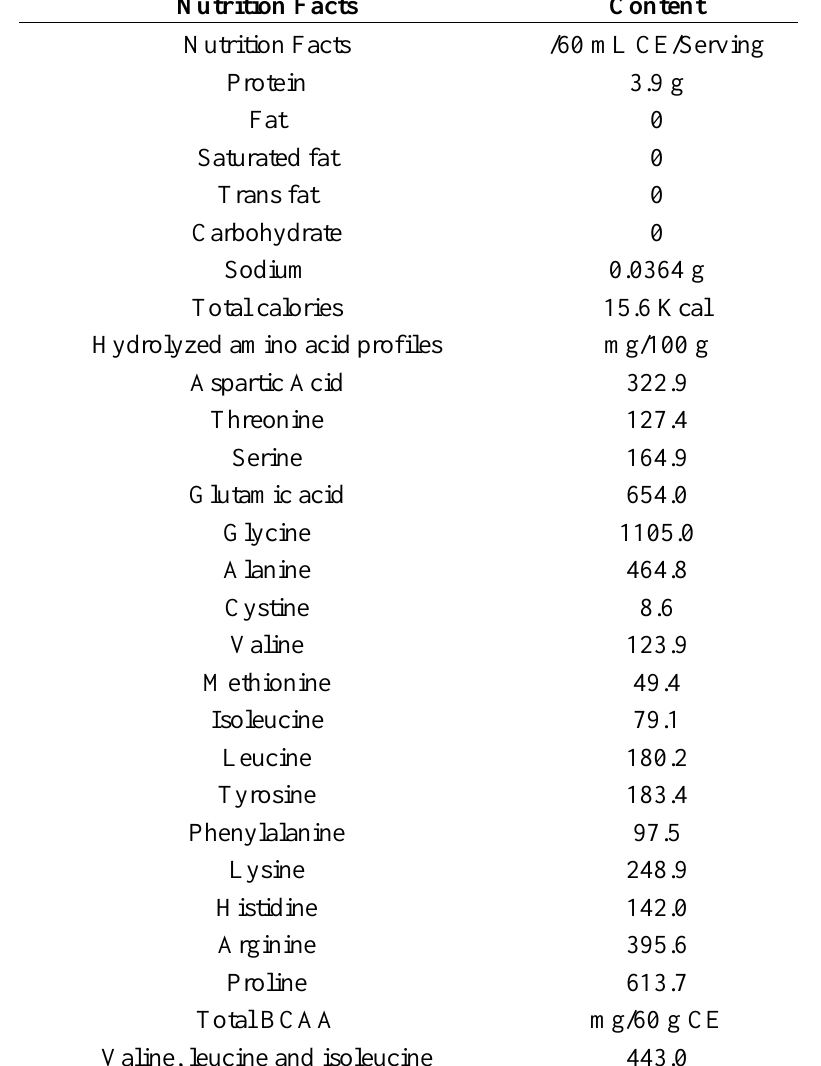
Table 3. Nutrition facts, hydrolyzed amino acid profiles and total branched-chain amino acids of chicken essence